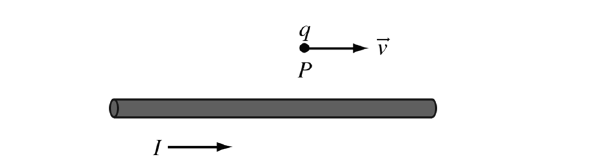
FIG. 5. The Sudden Charge question, adapted from item 2 in Furió and Guisasola [4]. FIG. 6. Final version of the Broadcast question, designed by the authors of the